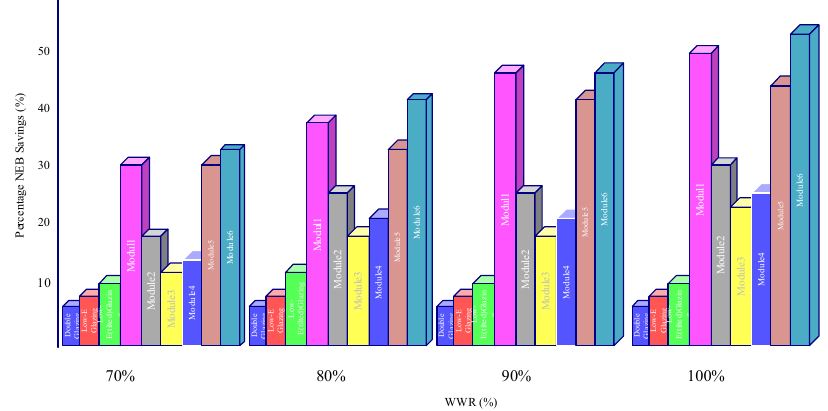
Figure 12. Percentage of total NEB (Net Energy Benefit) savings for different window types [62].